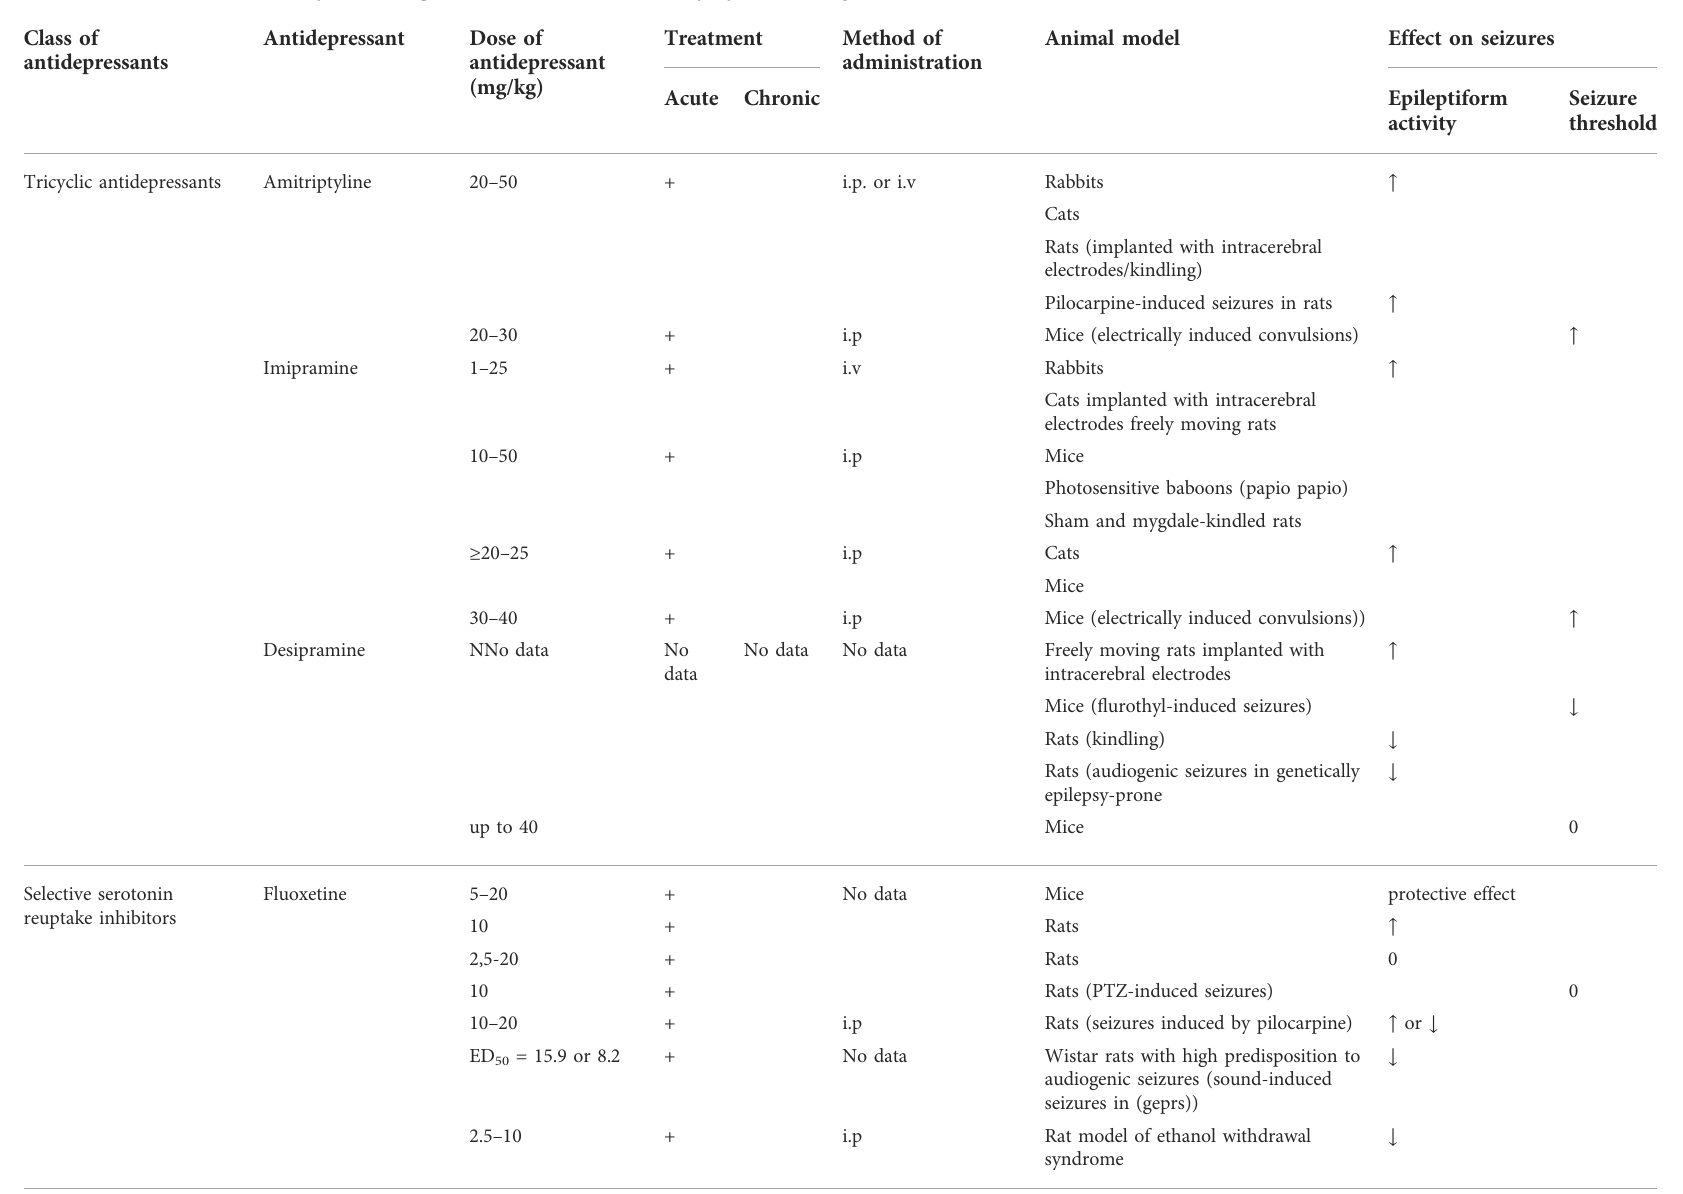
TABLE 1 In fl uence of various antidepressant drugs on the seizure threshold and epileptiform activity. Class of